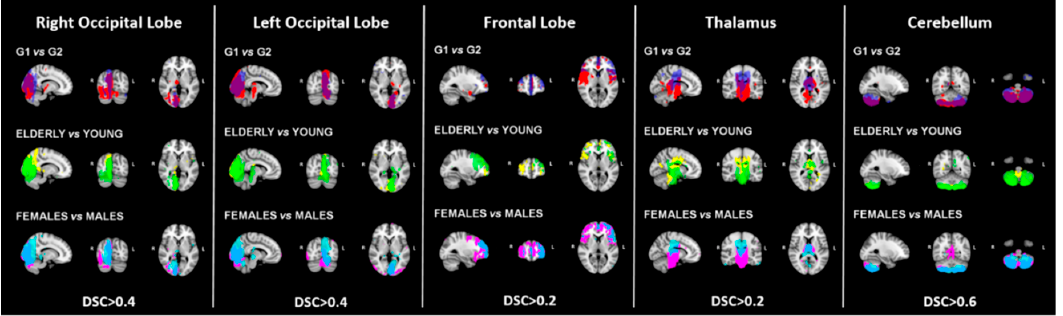
Figure 1. The overlaps of the most consistent CBF-ICs derived from the different splitting are displayed in the figure. The first row shows the comparison between age and sex-matched groups G1 and G2 (G1 is displayed in red while G2 in blue), the second compares groups divided according to the median age (elderly in yellow and young in green), and the third row is the overlap between males vs. females CBF-ICs (light-blue and pink respectively). Legend: G1 = group 1, G2 = group 2, DSC = Dice Similarity Coefficient.